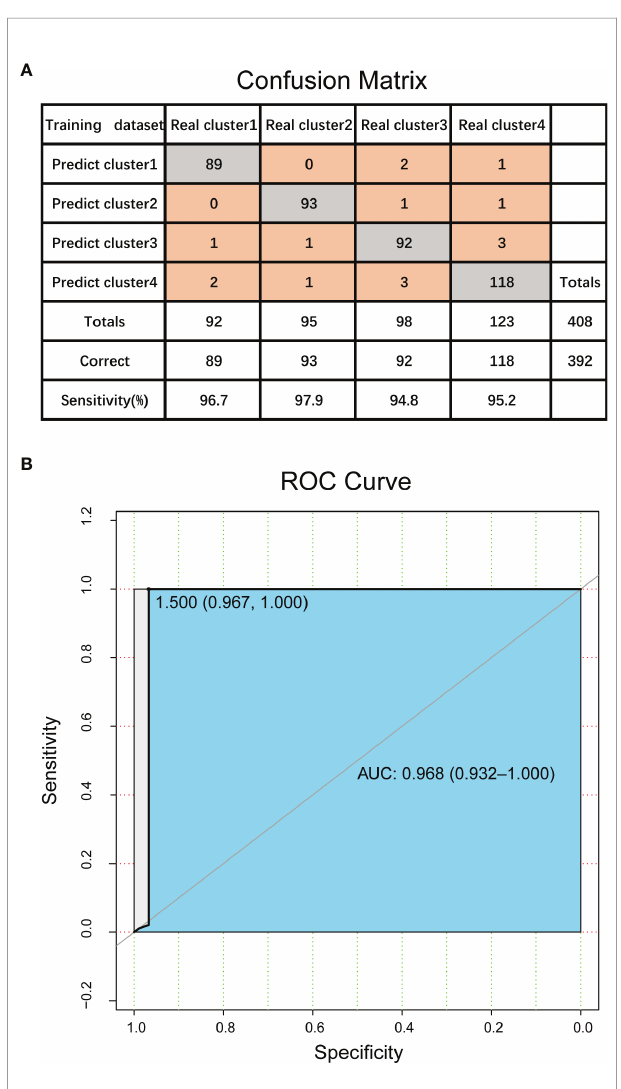
FIGURE 4 | Validation of DNA methylation molecular subtypes and classi fi cation features in bladder cancer. (A) The confusion matrix of classi fi cation model. (B) ROC curve of classi fi cation